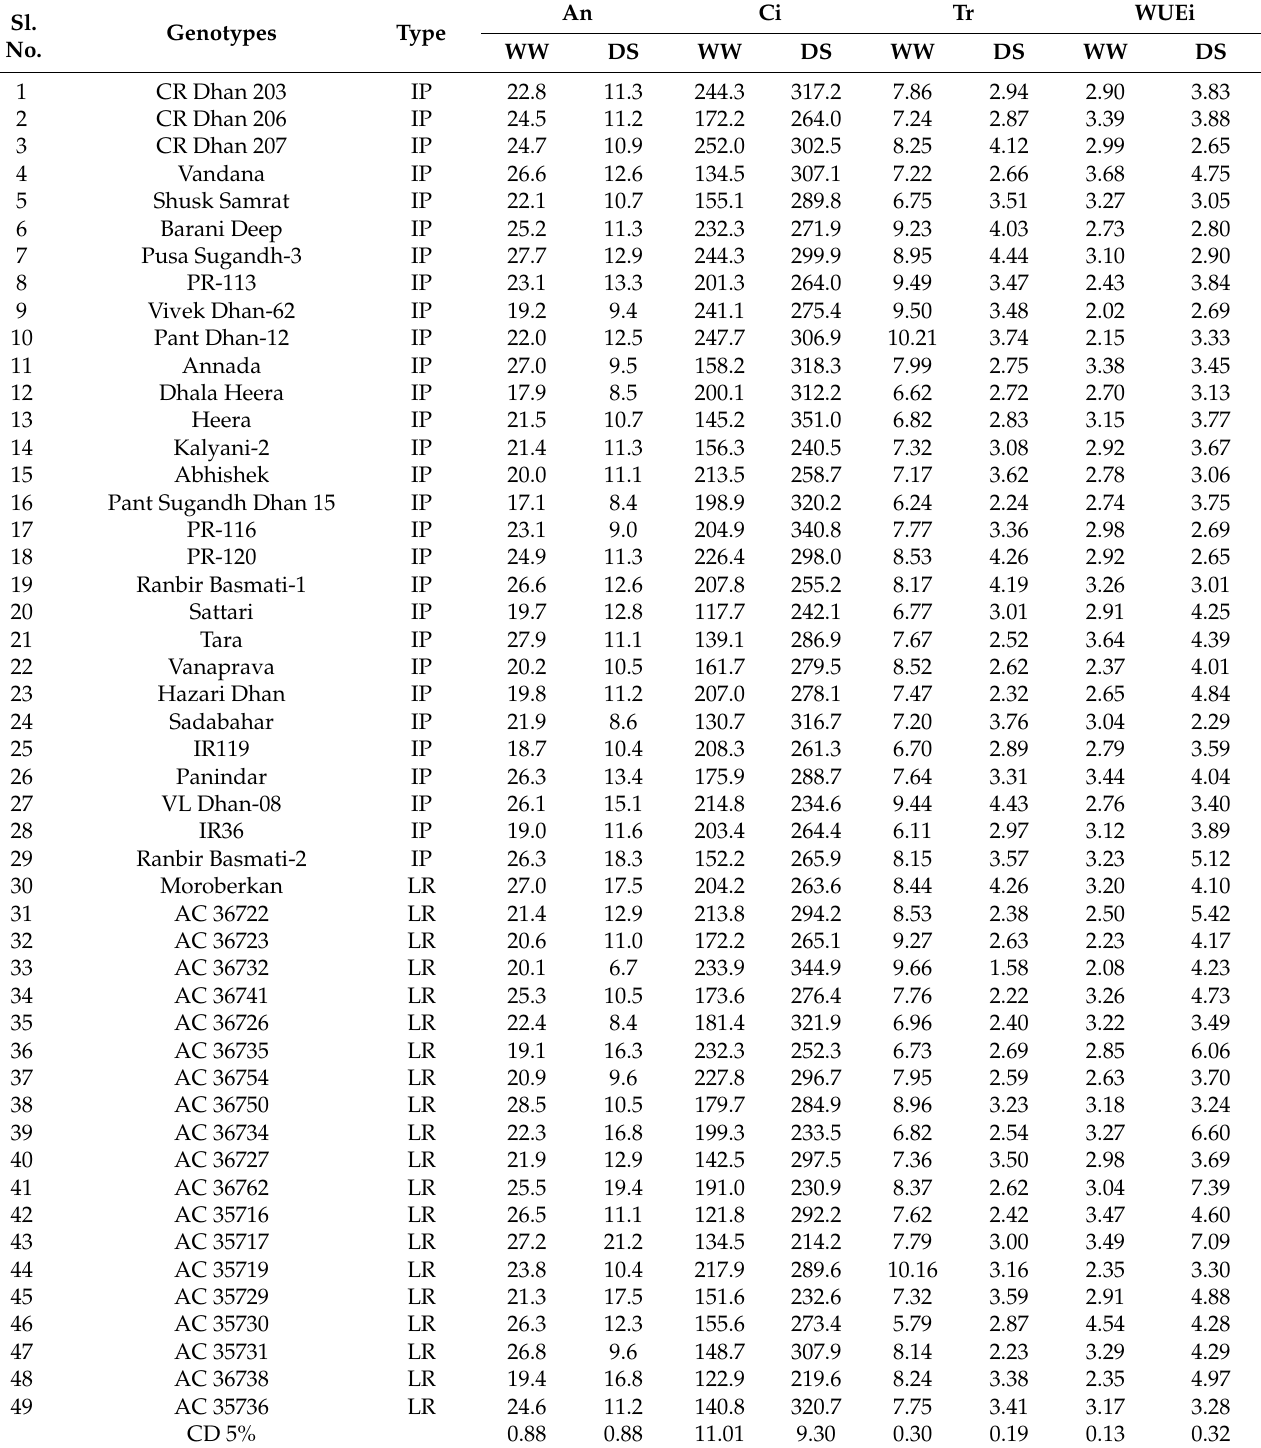
Table 3. Variation in photosynthetic gas exchange traits under well-watered and drought stress conditions in 49 rice